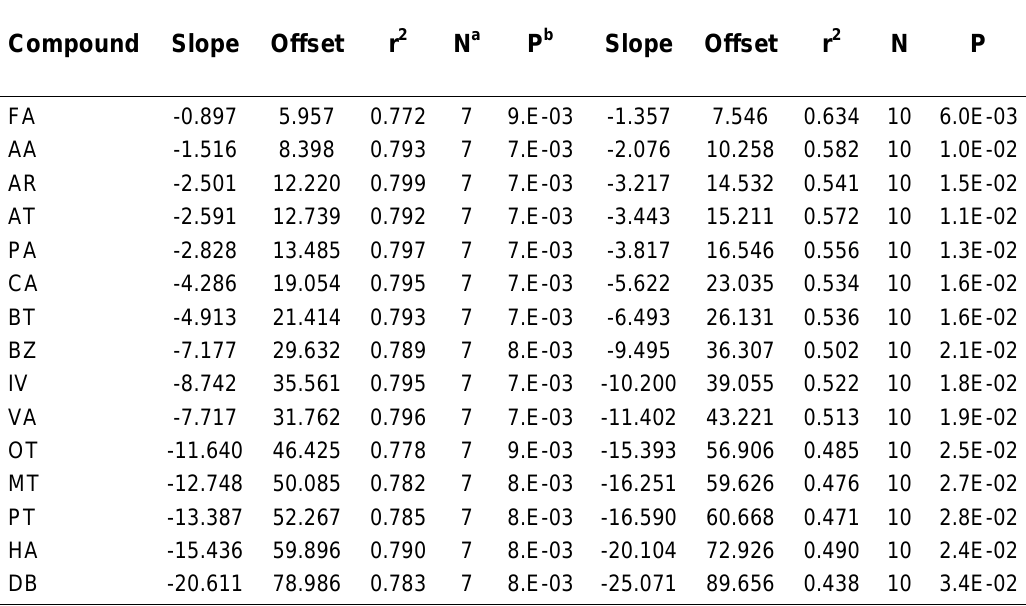
Results of Correlation Analysis between M/W Ratio for All 15 CCs Obtained in Three Types of Data (R Value, Slope Value, and Run Time) s C. M/W Ratio vs. Run Time